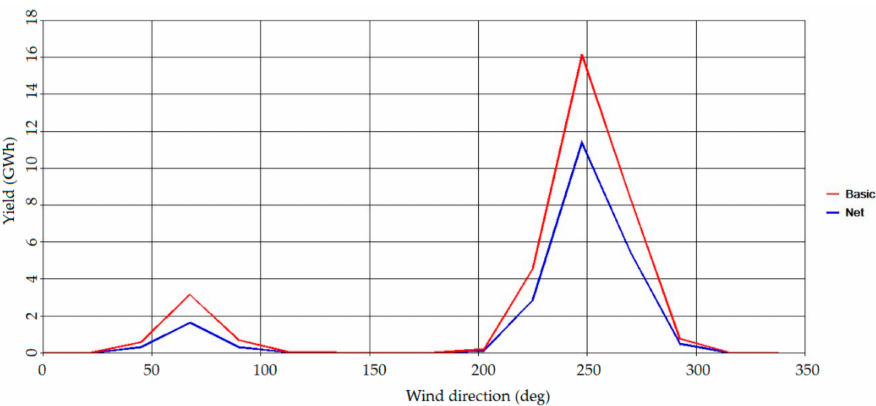
Figure 15. Basic and net energy yield for each turbine for the initial layout.